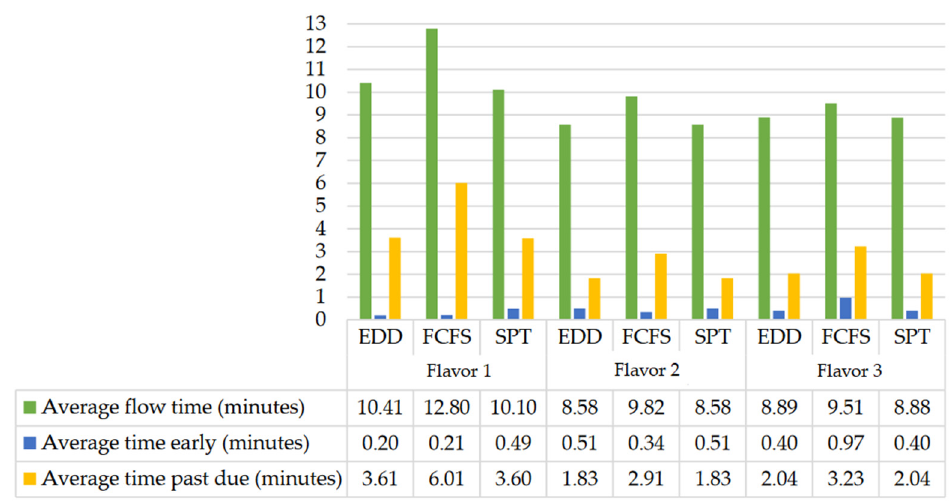
Figure 5. The values of performance measures for all flavors using three one-dimensional rules. The average-time-past-due performance measure is valued the most by management, and the SPT rules produced better results than the other rules when dairy product was filled with the various required flavors. As a result, the bottles are handled following the SPT rule at the dedicated filling locations for each